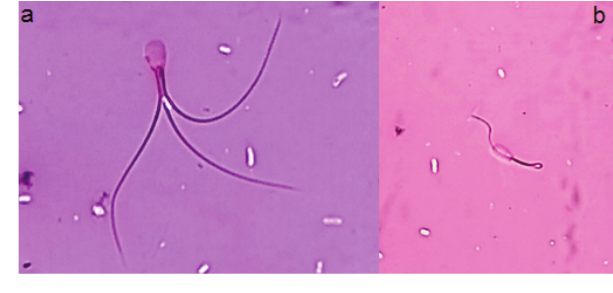
Figure 2. Sperm abnormality observed under Phase Contrast Microscope (200x): a) Tripletai; b) Distalreflex (coiled bent